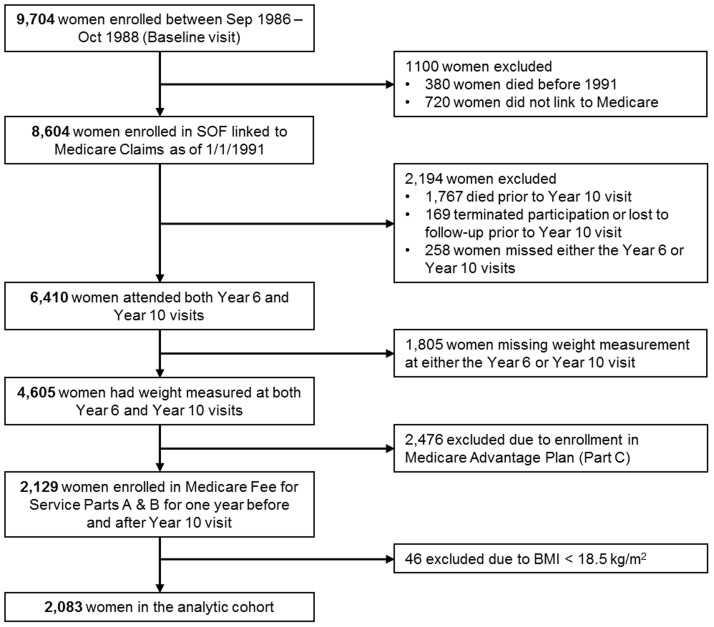
Flow diagram of analysis cohort.